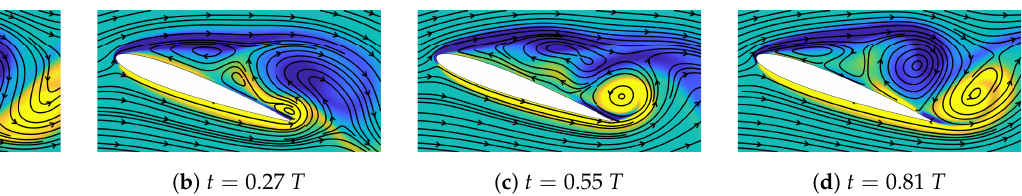
Figure 5. Vorticity contours at different time instants in one period of lift cycle for the flap-less airfoil case.